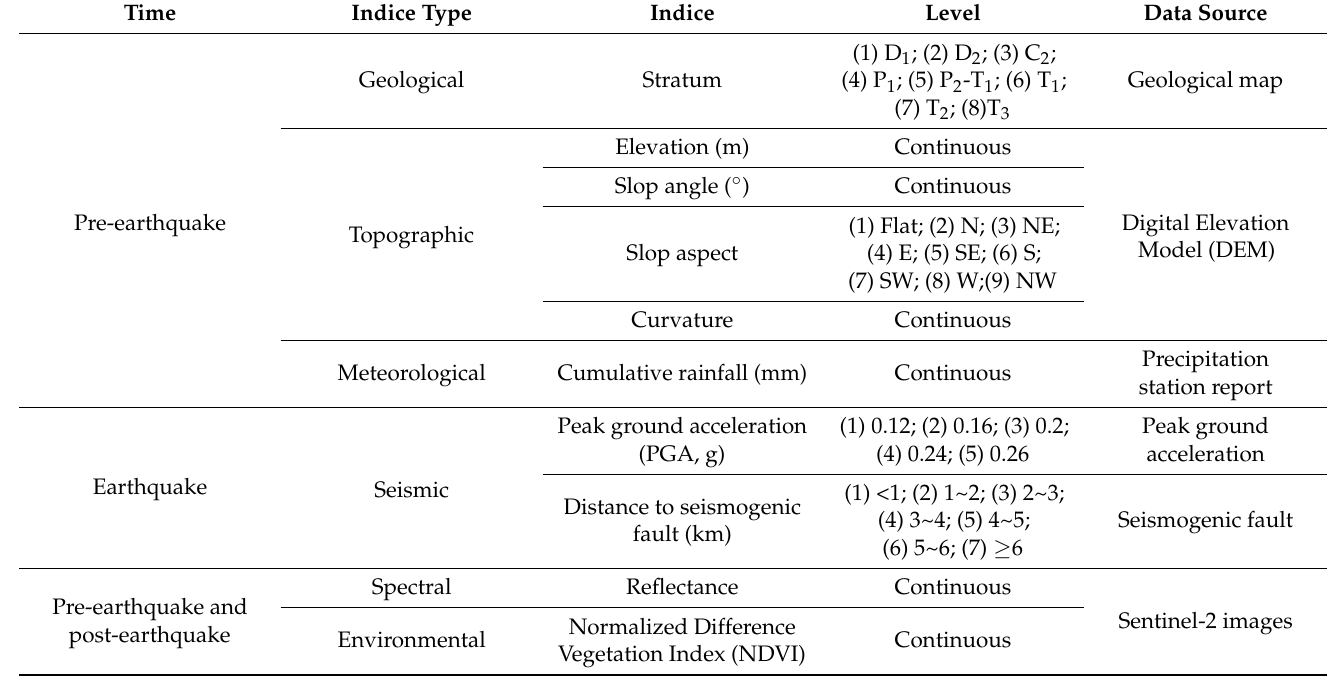
Table 2. Recognition indices for coseismic landslides recognition. The cumulative rainfall indice was obtained by the Kriging interpolation method based on the precipitation station